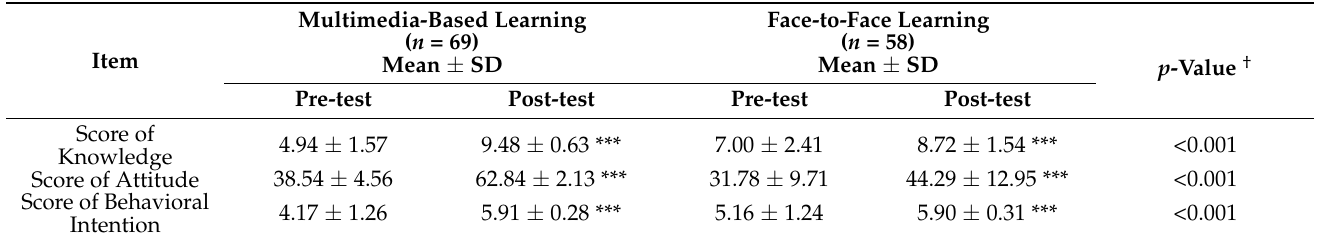
Table 2. Distributions and comparisons of the scores in knowledge, attitude, and behavioral intention.